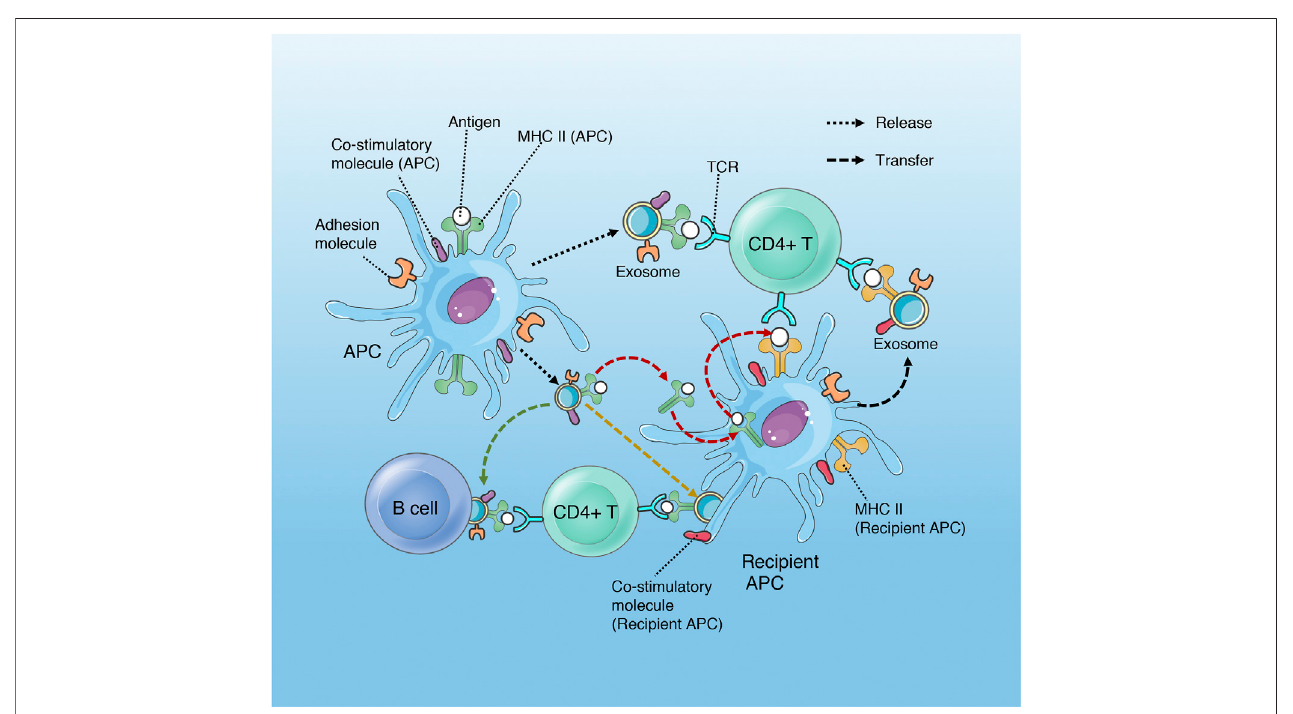
FIGURE2| Role ofexosomes in antigenpresentation.Exosomesreleased byAPCs (DCs) containMHC II- antigen peptide complexes(MHC II-p) and can present antigen to CD4+T cell directly, deliver antigen to MHC II of recipient APC (red arrow), present antigen via cross-dressing (orange arrow) and transport MHC II-p to B cell (green arrow). Although only MHC II and CD4+ T cell are shown, exosomal MHC I has a similar process in the regulation of CD8+ T cells.